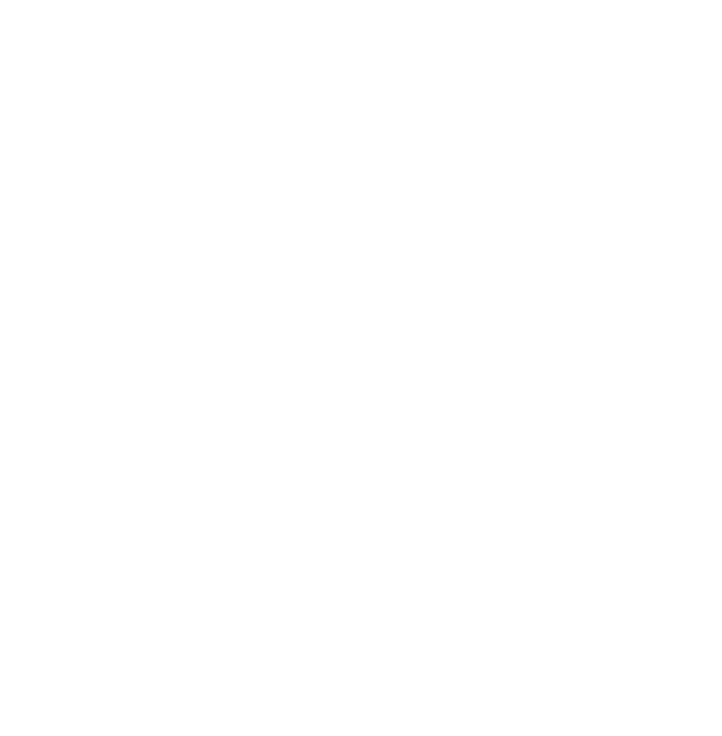
Figure 11. Particle distribution graph for PNSC on AQEF at τ f 1 / 2 = 1.90 min, C 0 = 119.26 g L −1 and K b = 0.0635 Lg −1 min −1 .